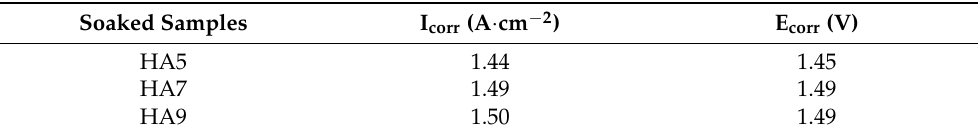
Table 3. Calculated corrosion potential and current density of the soaked